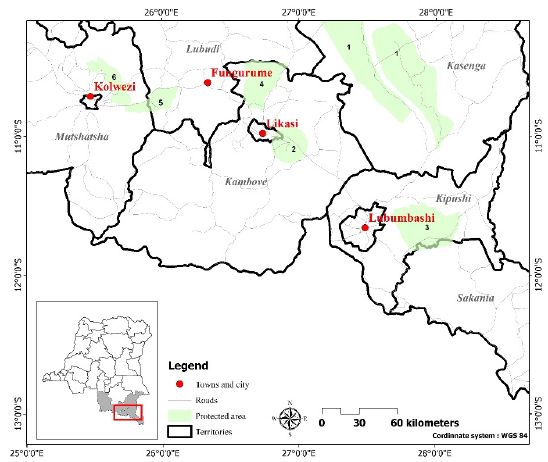
Figure 1. Location of study sites in Southeastern Katanga: Lubumbashi, Likasi, Kolwezi and Fungurume. These agglomerations are located near protected areas (Kundelungu National Park (1), Lufira Biosphere Reserve (2), hunting domains such as Kiziba-Baluba (3), Mufufya (4), Basse Kando (5), Tshangalele (6)). Lubumbashi and Likasi are located in Upper-Katanga province, respectively, in Kipushi and Kambove territories, while Kolwezi and Fungurume are located in Lualaba province, respectively, in Mutshatsha and Lubudi territories.